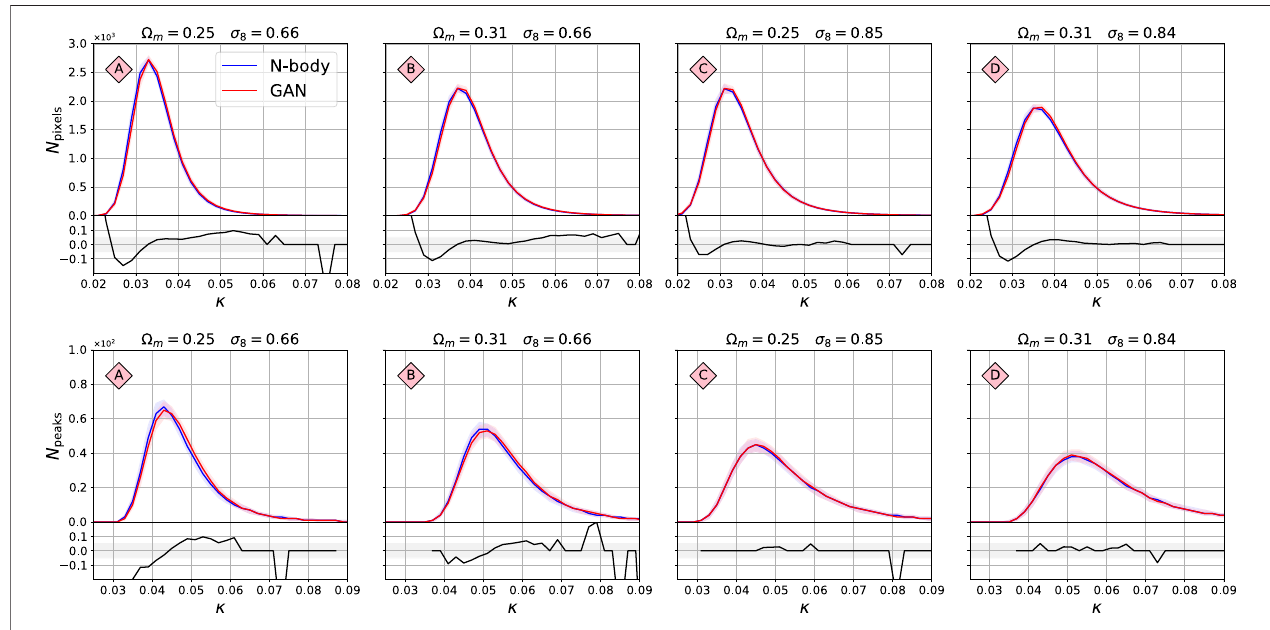
FIGURE 5 | Comparison of histogram of pixel values (top) and peaks (bottom) between the original N-body and the GAN-generated maps. Models A, B, C, D correspondtotheonesmarkedin Figure 2 .The x -axis value κ isthemappixelintensity. Thesolidlineisthemedian histogram from5,000randomlyselectedmaps. The bands correspond to 32 and 68% con fi dence limits of the ensemble of histograms. The lower panels show the fractional difference between the median histograms.